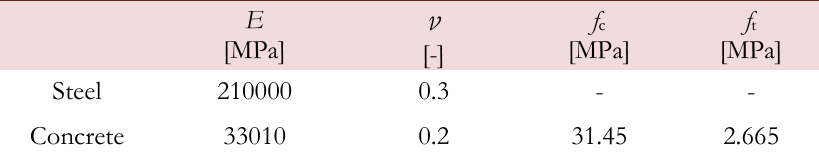
Table 2: Mechanical input parameters for the material used in the ATENA and ABAQUS